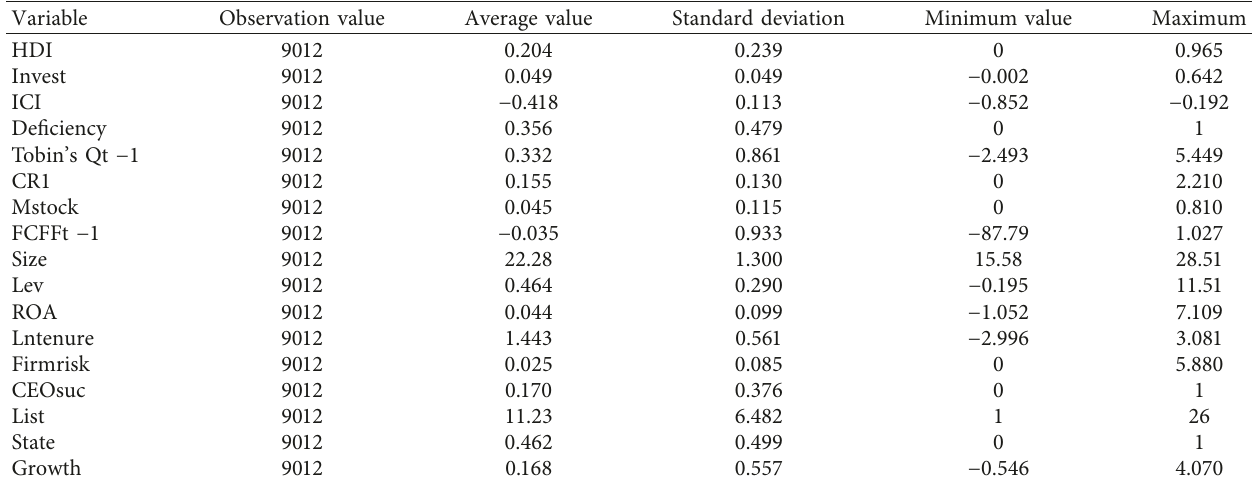
Table 2: Descriptive statistics.